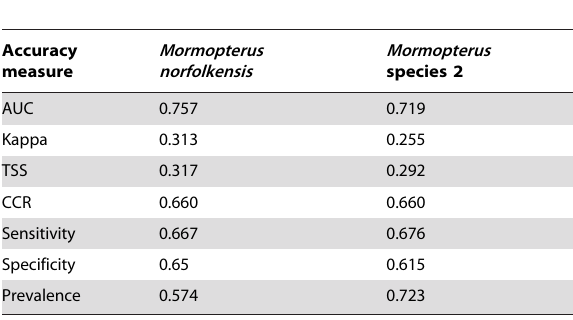
Table 2. Predictive accuracy of regional-scale models [25] to local-scale data collected during this